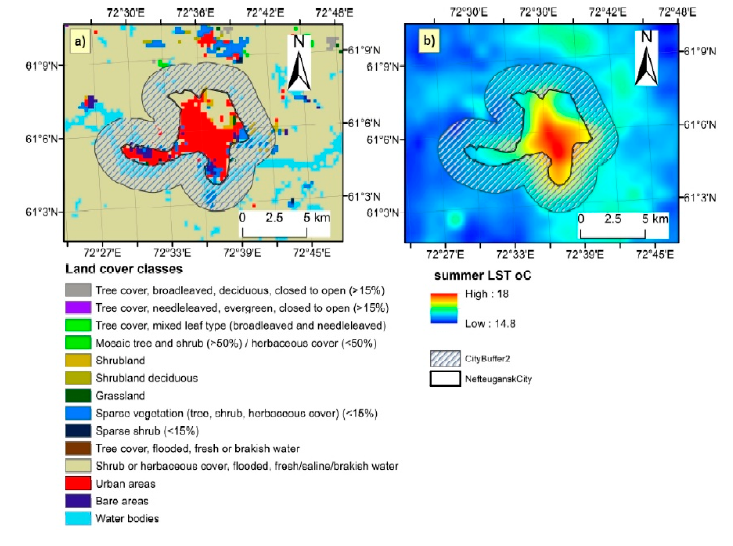
Figure 3. Example of CCI ‐ LC and LST use in the urban study by [74].